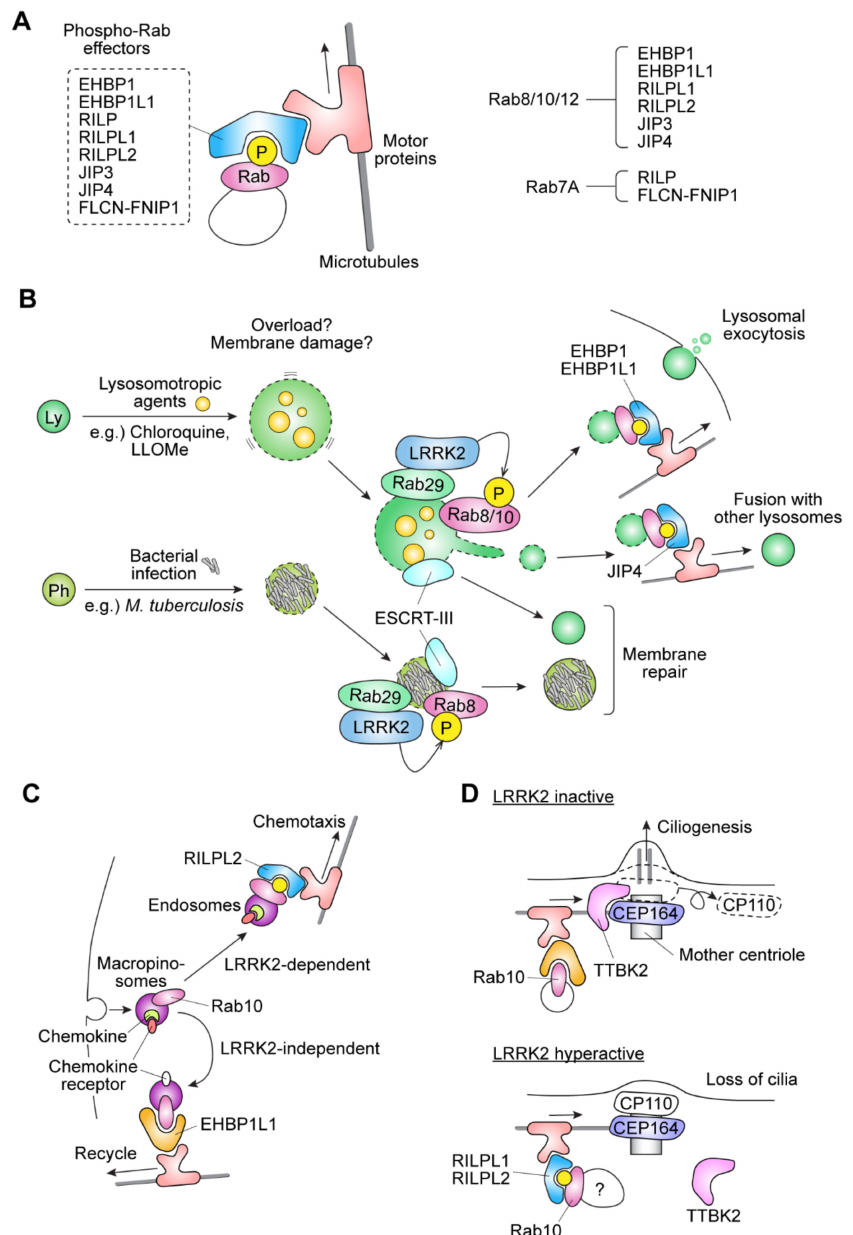
Figure 3. Proposed biological roles of Rab phosphorylation by LRRK2. ( A ) Proposed effectors of phosphorylated Rab proteins. They form complexes with motor proteins, thereby, in most cases except Folliculin (FLCN)-FLCN-interacting protein 1 (FNIP1), accelerating cargo transport. ‘P’ in a yellow circle and blank yellow circles mean phosphorylation. ( B ) Phosphorylation of Rab8/10 by LRRK2 plays important roles in macrophages under conditions such as lysosomal stress and bacterial infection. Ly: lysosomes; Ph: phagosomes. ( C ) Phosphorylation of Rab10 by LRRK2 functions as a molecular switch upon macropinocytosis; the macropinosomes are recycled back to the plasma membrane in a LRRK2-independent manner, whereas LRRK2-mediated phosphorylation of Rab10 activates a pathway in which the macropinosomes become maturated to signaling endosomes that somehow activate chemotactic pathways. ( D ) Aberrant phosphorylation of Rab10 by LRRK2 abnor- mally accelerates the transport of the Rab-interacting lysosomal protein-like protein 1/2 (RILPL1/2) cargo, the accumulation of which, in the pericentriolar region, might prevent centrosomal protein 164 (CEP164) and tau-tubulin kinase 2 (TTBK2) from localizing to the mother centriole, maintain centrosomal protein of 110 kDa (CP110) on the mother centriole and inhibit membrane transport necessary for